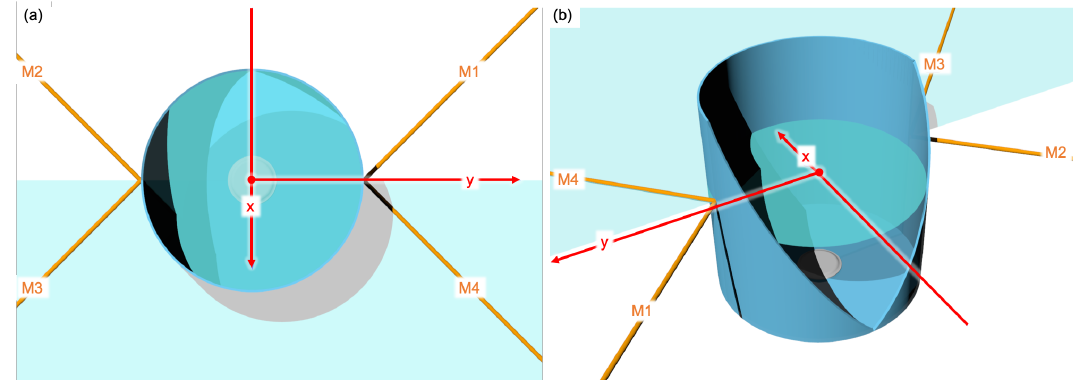
Figure 2. Rendered view of the cylinder from top ( a ) and from the side ( b )—coordinate system moved due to better